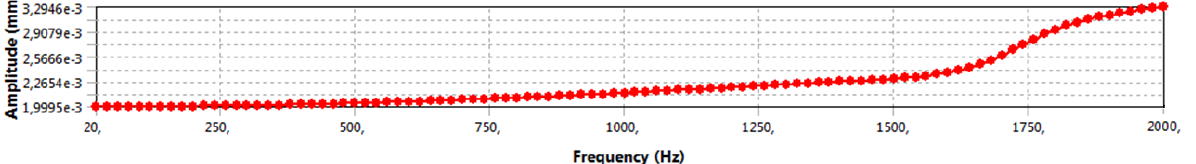
Figure 6. The amplitude-frequency response of the fixture with incomplete locating when machining the surface of a one-piece connection rod.